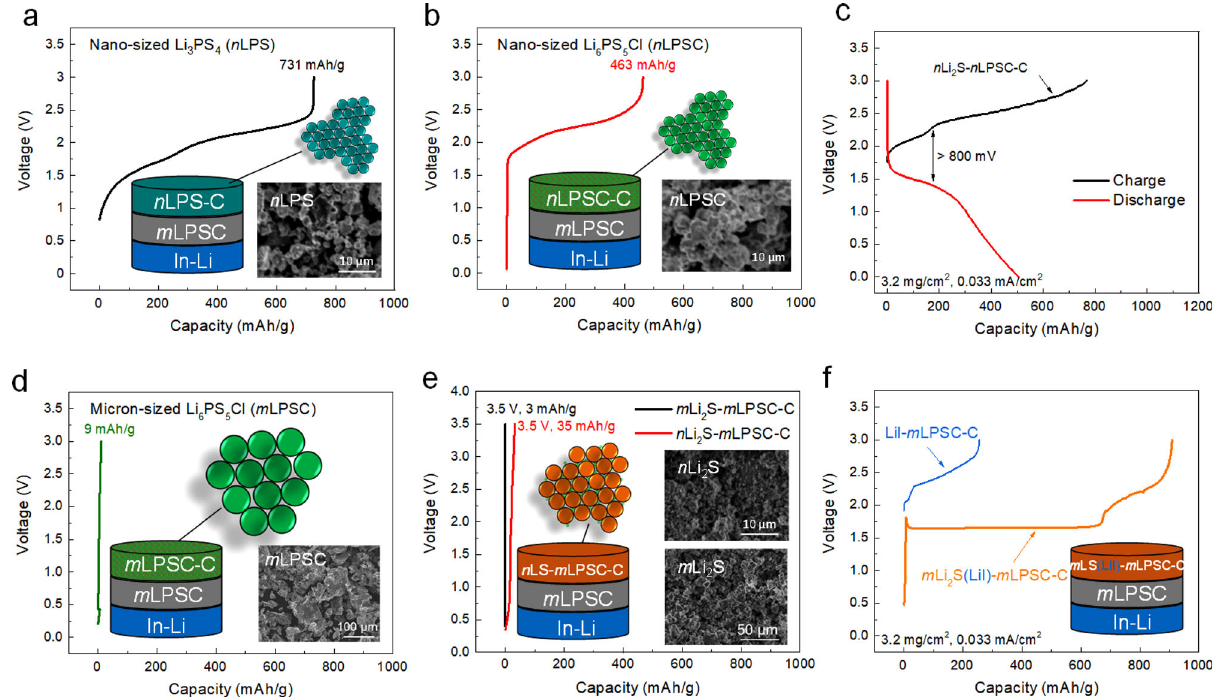
Fig. 1 Electrochemical characterization of nano- and microsize solid-state sulfur electrolytes and sulfur-based positive electrodes. a , b voltage pro fi les of ( a ) nanosized n LPS-C and ( b ) n LPSC-C cathodes; In this con fi guration, thus by excluding the active material, the solid electrolyte acts as the active material. This is enabled by the presence of conductive carbon, providing abundant interfaces where redox reactions can occur. Therefore, this allows direct evaluation of the redox activity of the solid electrolyte that causes its decomposition. c Voltage pro fi les of n Li 2 S- n LPSC-C cathode. d , e Voltage pro fi les of micron-sized m LPSC-C, m Li 2 S- m LPSC-C, and n Li 2 S- m LPSC-C (Li 2 S is abbreviated as LS in the schematic fi gure). f Activation voltage pro fi les of m Li 2 S(LiI)- m LPSC-C and LiI- m LPSC-C cathodes; For all voltage pro fi les, the current density is 0.033 mA/cm 2